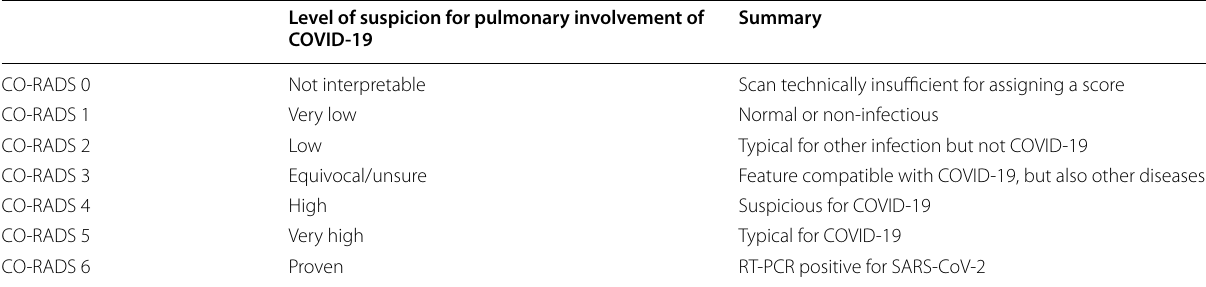
Table 1 CO‑RADS classification